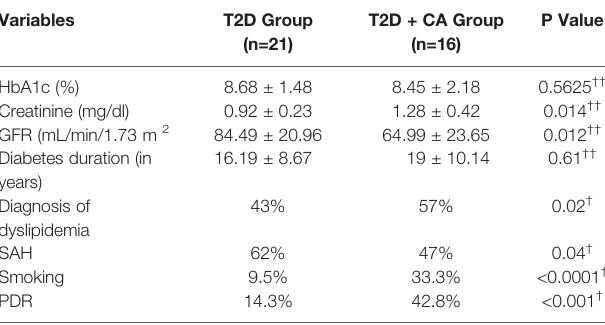
TABLE 2 | Comparative analysis of clinical, demographic, and metabolic characteristics of type 2 diabetes (T2D) patients with and without Charcot arthropathy